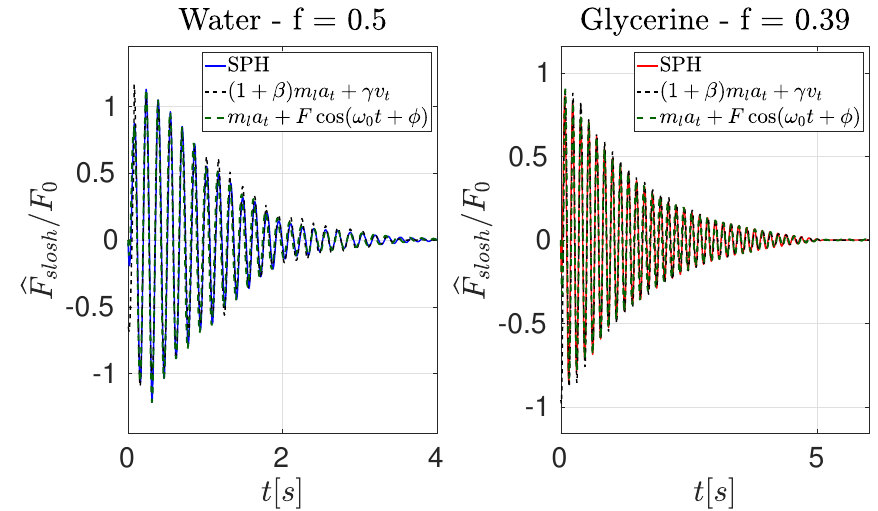
Figure 15. Filtered nondimensional sloshing force computed directly from the SPH formulation and also using the alternative force reconstruction given by the Equation (25).